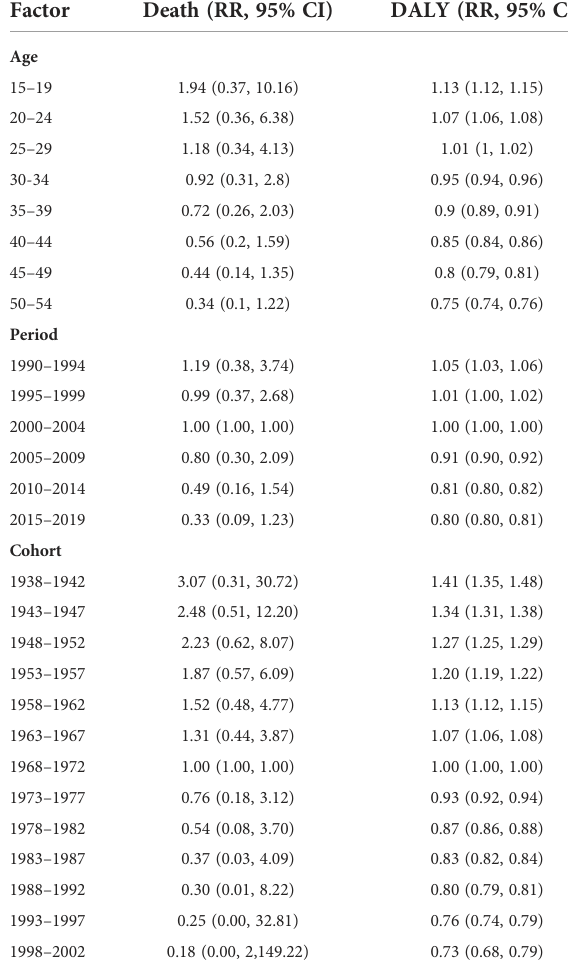
TABLE 3 Age − period − cohort model analysis results of endometriosis death and DALY and relative risks (RR) in